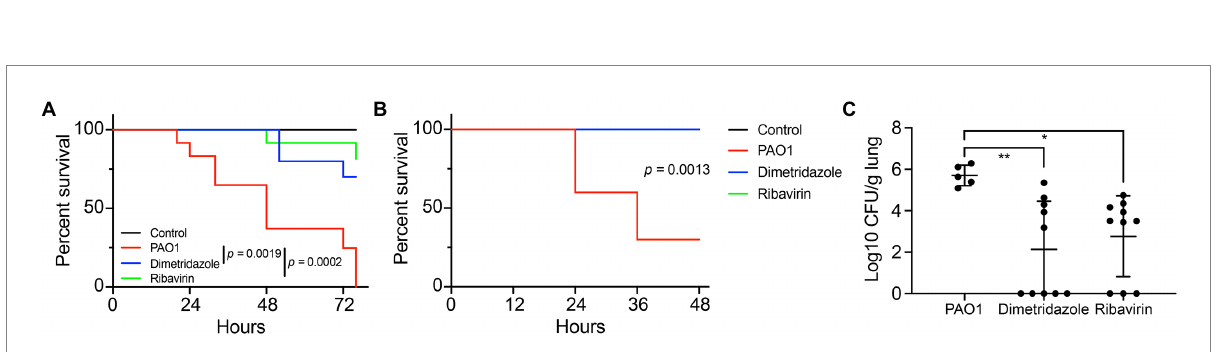
FIGURE 8 Dimetridazole or Ribavirin effectively protects the host from Pseudomonas aeruginosa infection. (A) Protection of Dimetridazole or Ribavirin (200 μ M) on Caenorhabditis elegans models infected with P. aeruginosa PAO1 in the fast killing assay. (B) Protection of Dimetridazole or Ribavirin (200 μ M) on mouse models intranasally instilled with P. aeruginosa PAO1. The survival curves were compared by using Log-rank (Mantel-Cox) test. (C) Number of residual P. aeruginosa PAO1 cells in mouse lungs treated or not treated with Dimetridazole or Ribavirin. One-way ANOVA test, * p < 0.05, ** p <